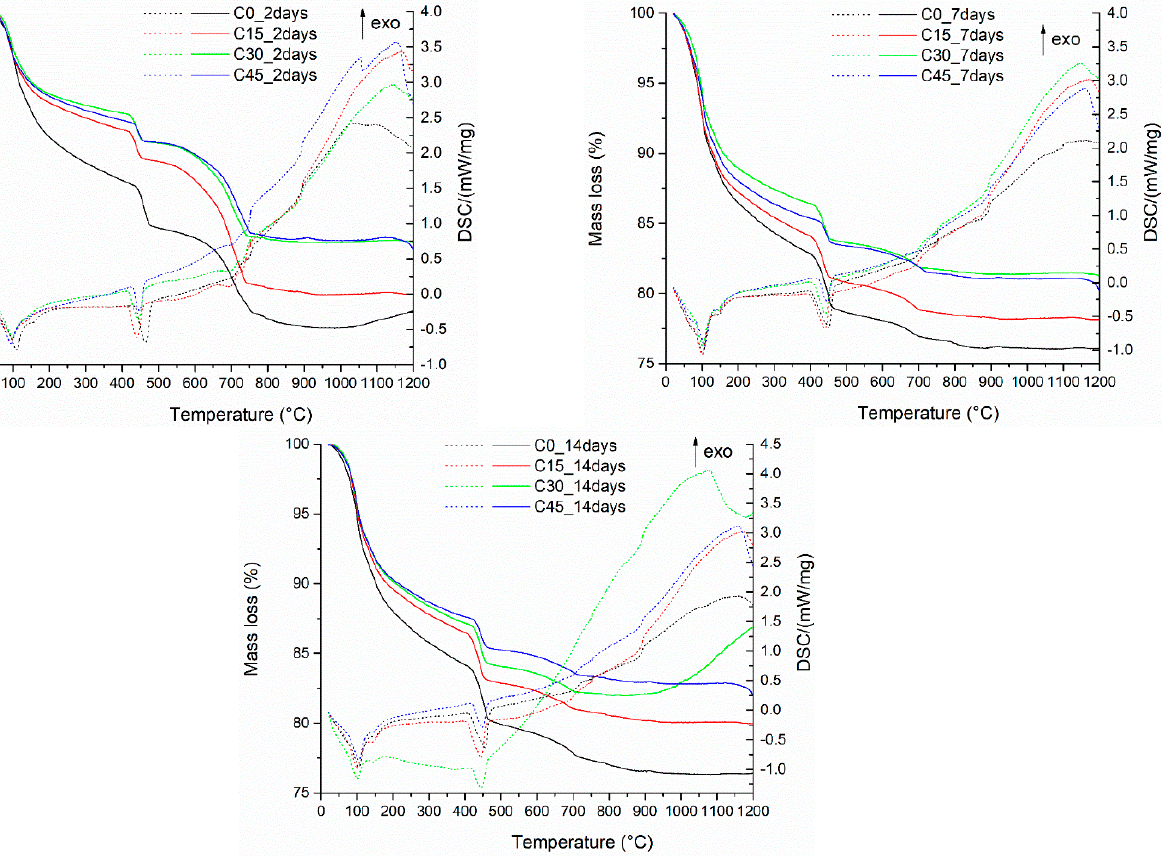
Figure 11. Differential thermal analysis of Portland cement samples containing waste in different proportions after 2, 7, and 14 days of hardening.